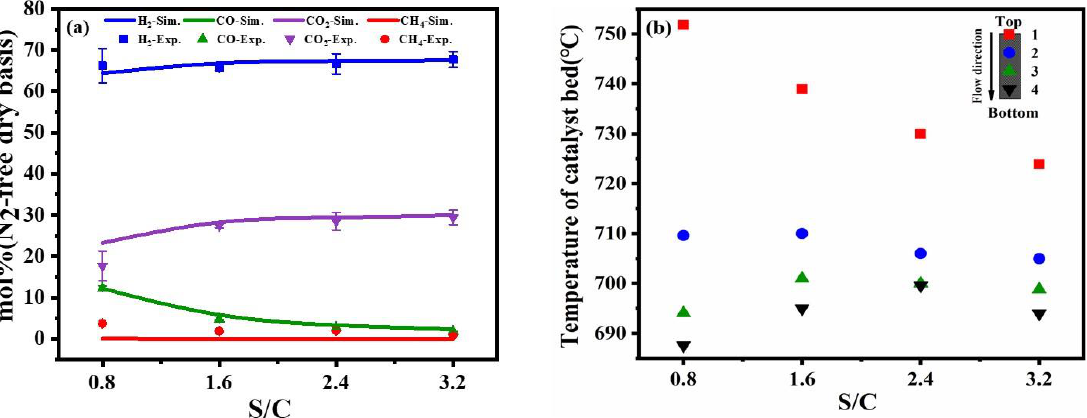
Figure 5. Comparison of experimental results and simulation results at different S/C molar ratios ( a ), the different temperature distribution in the catalyst bed ( b ) (reaction condition: temperature = 700 °C, the flow rate of toluene = 0.2 mL/min, the flow rate of dry air = 317.4